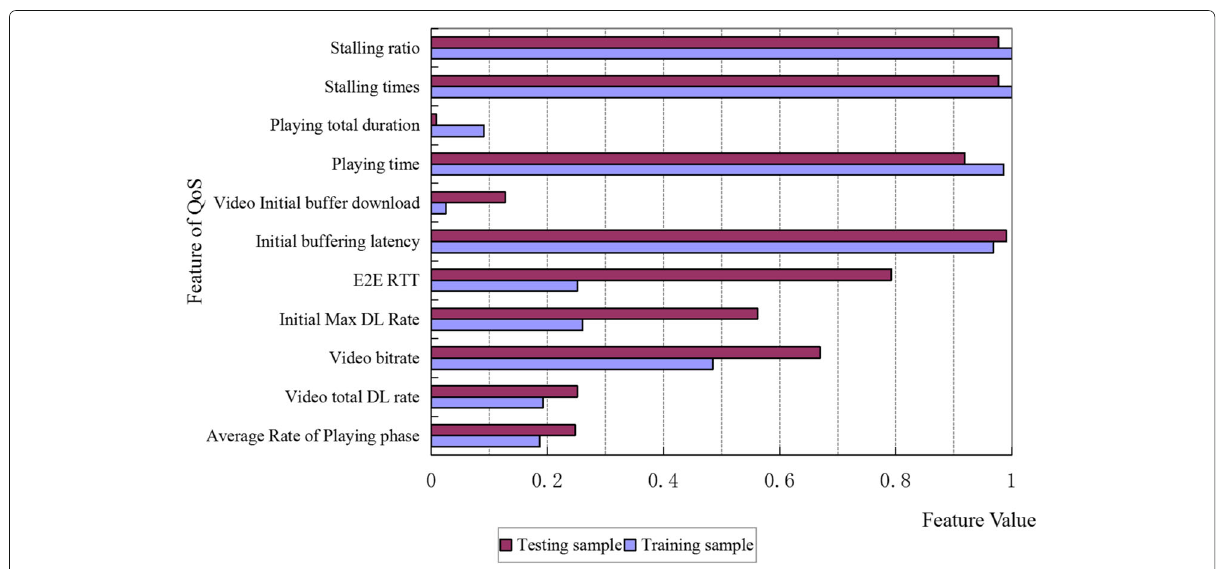
Fig. 7 Training samples versus testing sample